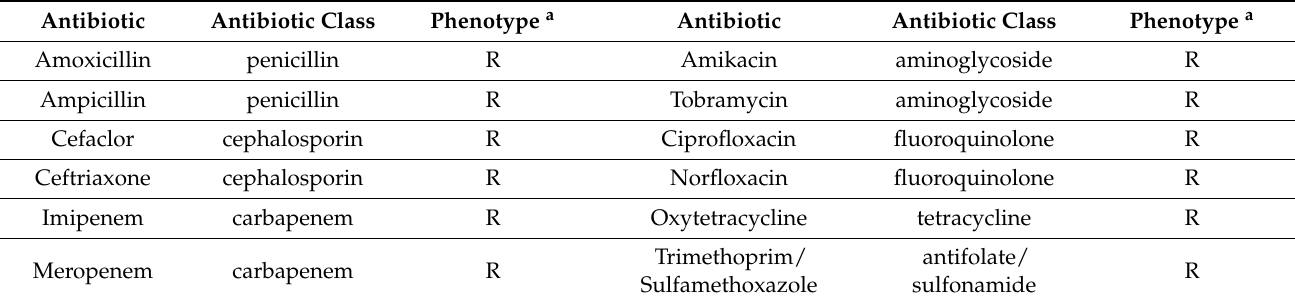
Table 1. Antimicrobial resistance profile of K. pneumoniae strain KPE16.